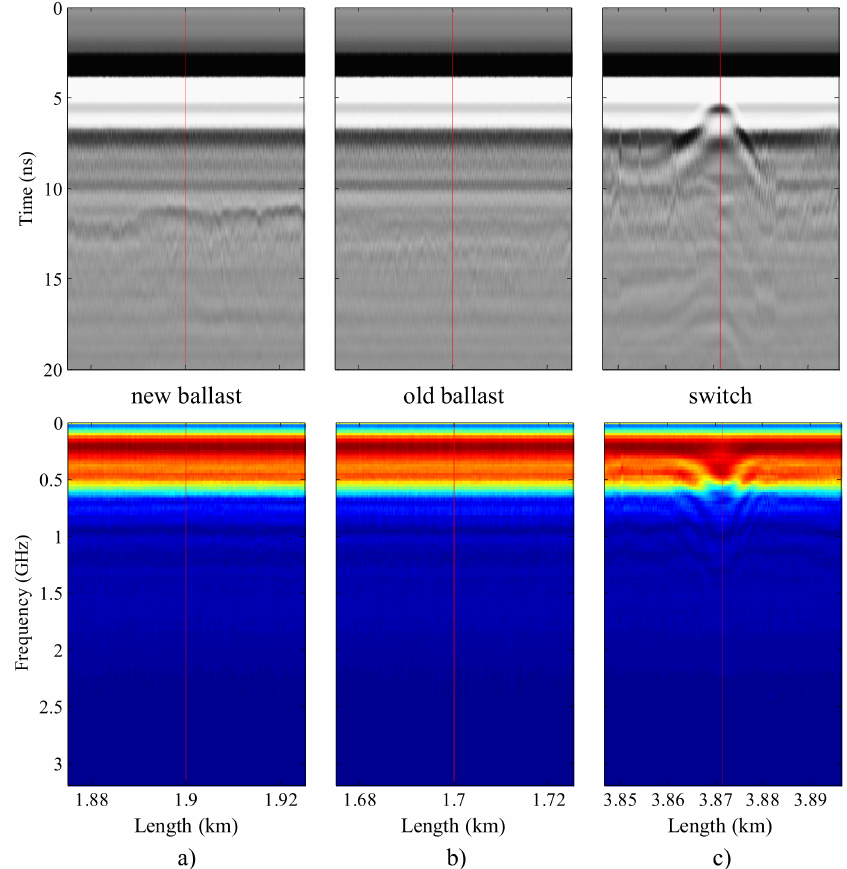
Figure 2. Example of spectrograms in time and frequency domain for (see Figure 1): ( a ) new ballast; ( b ) old ballast and ( c ) over a